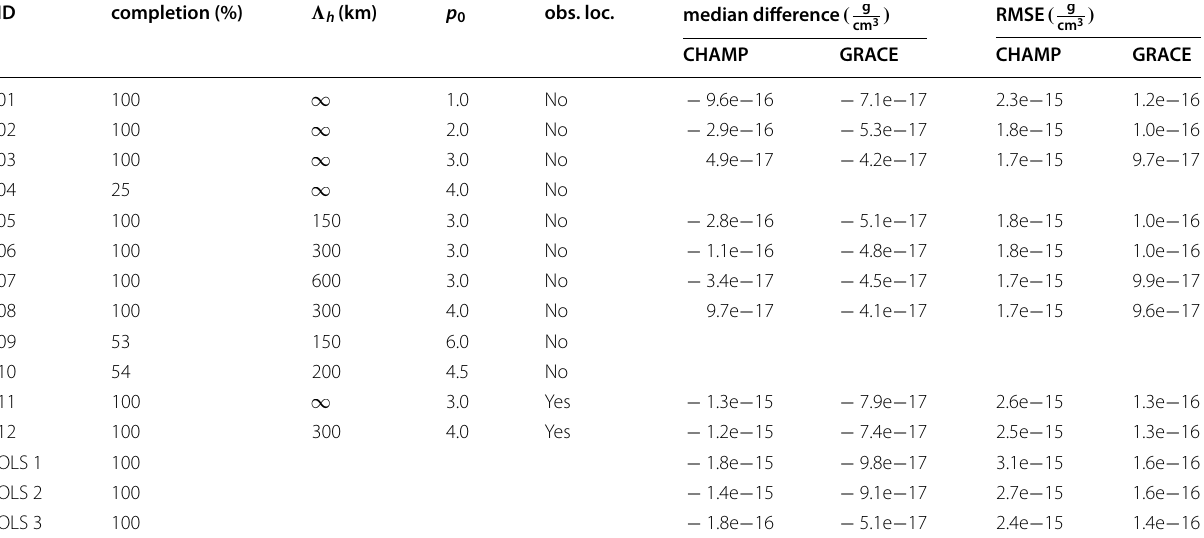
Table 3 Setups for the data assimilation